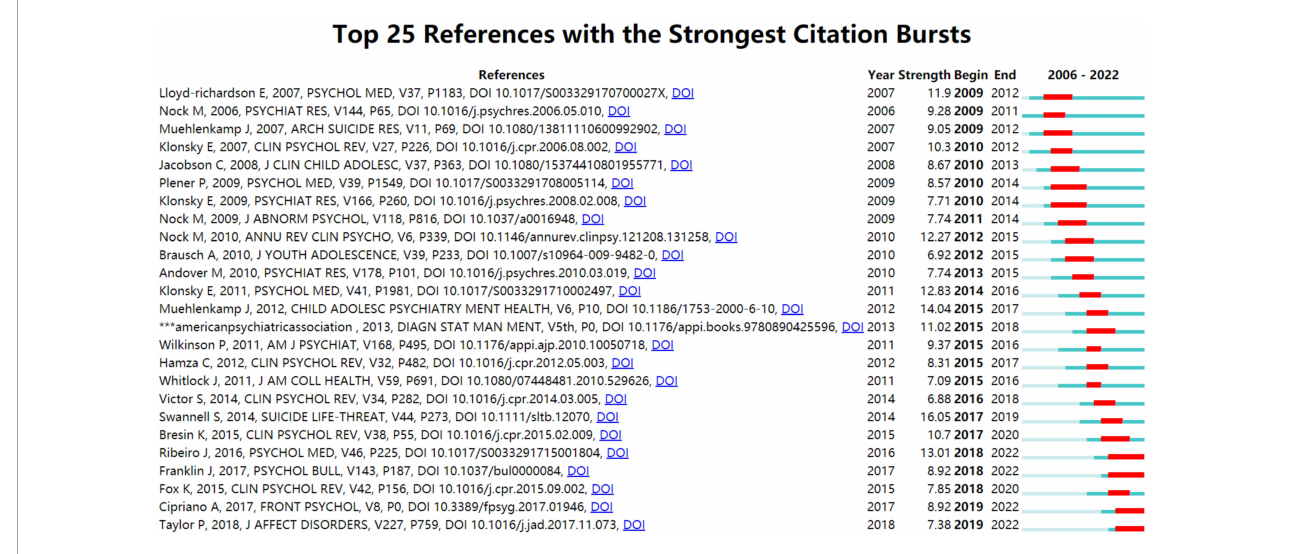
FIGURE11 Top 25 references with the strongest citation bursts generated by CiteSpace. The blue line is the time interval, the red line is the time period with reference